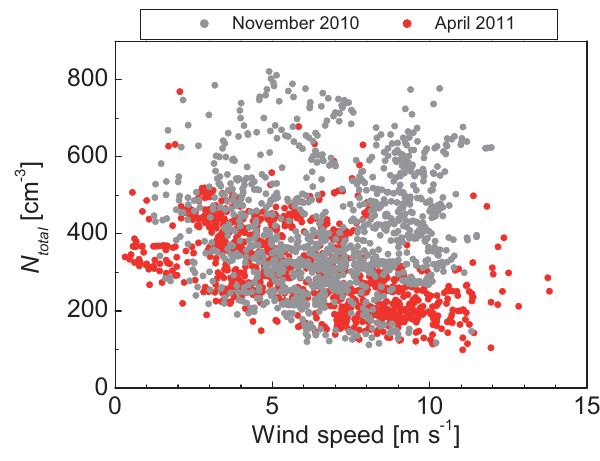
Figure 10. Comparison of horizontal wind speed to N total .